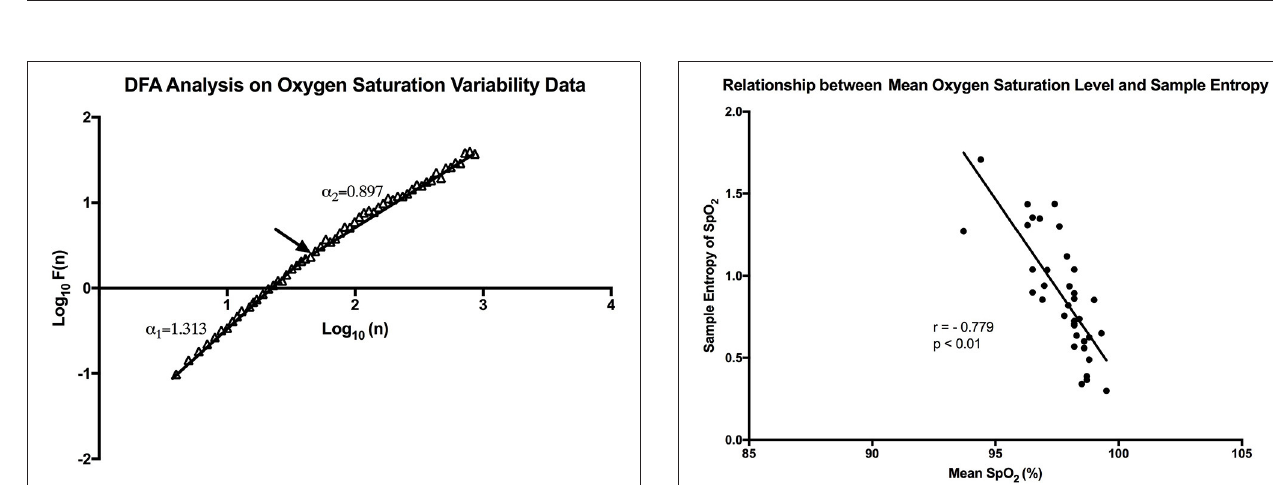
FIGURE 3 | Graph showing the linear trend that exists between mean SpO 2 level and total variability. Each point represents a participant in the study. “r” represent the Pearson correlation coefficient.